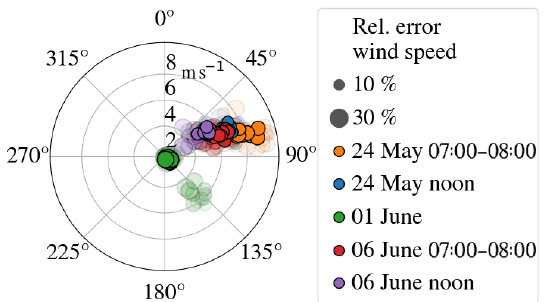
Figure 6. The wind rose indicates wind direction and wind speed as occurred during the transects. Different colours mark different days. Size of the circles corresponds to the relative standard devia- tion in % resulting from averaging wind speed horizontally, within the PBL, and over time. Solid circles mark the best-estimate wind information whereas transparent circles mark wind information that stems from the individual wind lidars directly. During the measure- ment periods, easterly winds prevailed. Note that for 1 June wind speeds are exceptionally